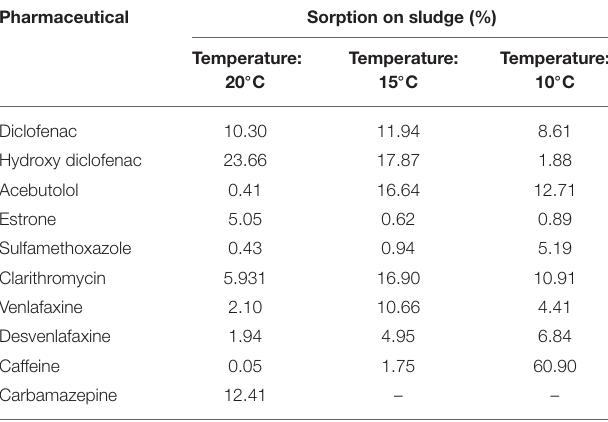
TABLE 3 | Sorption (%) of pharmaceuticals in SMBR at varying operating temperature.